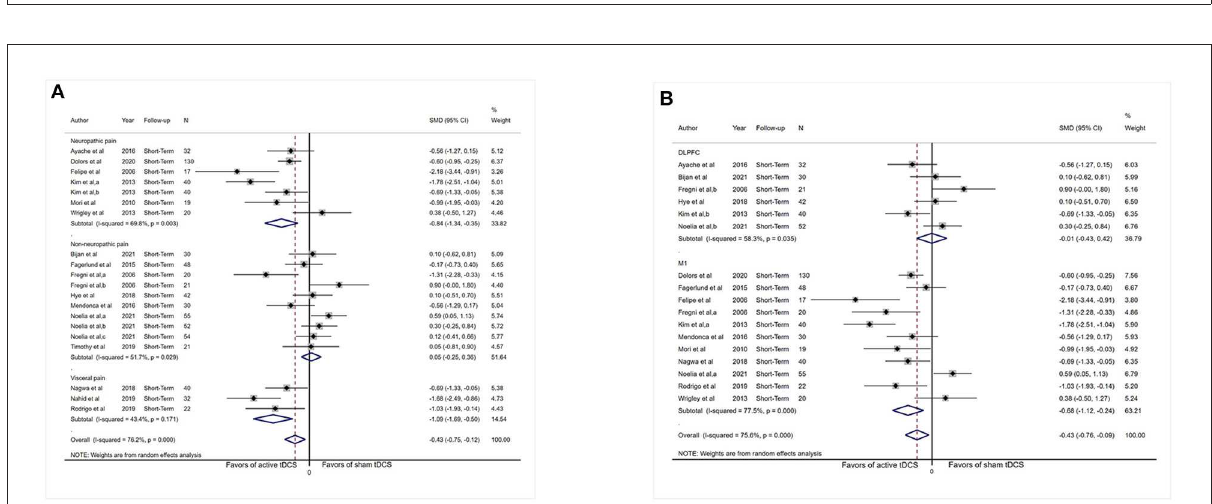
FIGURE3 Forest plot showing SMDs in pain intensity scores from data of short-term studies. (A) Sub-analysis of pain intensity scores by different types of chronic pain patients. (B) Sub-analysis of pain intensity scores comparing the stimulation of M1 with DLPFC. CI, confidence interval; SMD, standard mean difference; tDCS, transcranial direct current stimulation; M1, motor cortex; DLPFC, dorsolateral prefrontal cortex; a, motor cortex; b, dorsolateral prefrontal cortex; c, operculo-insular cortex.